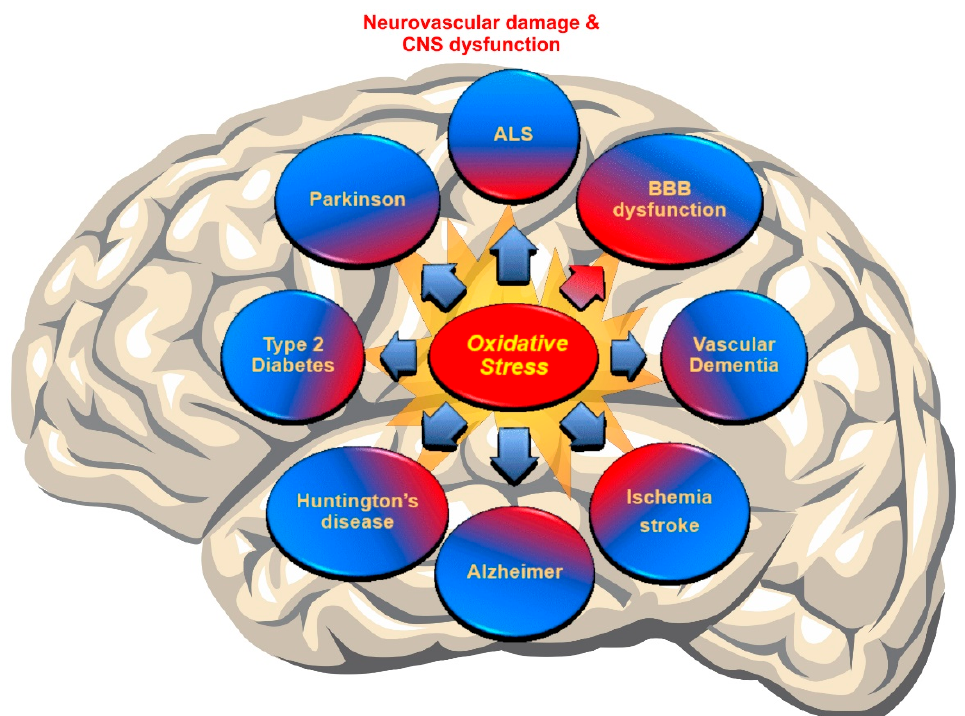
Figure 2. Schematic representation of the Cerebrovascular and neurodegenerative diseases associated with impaired redox metabolism and oxidative stress.